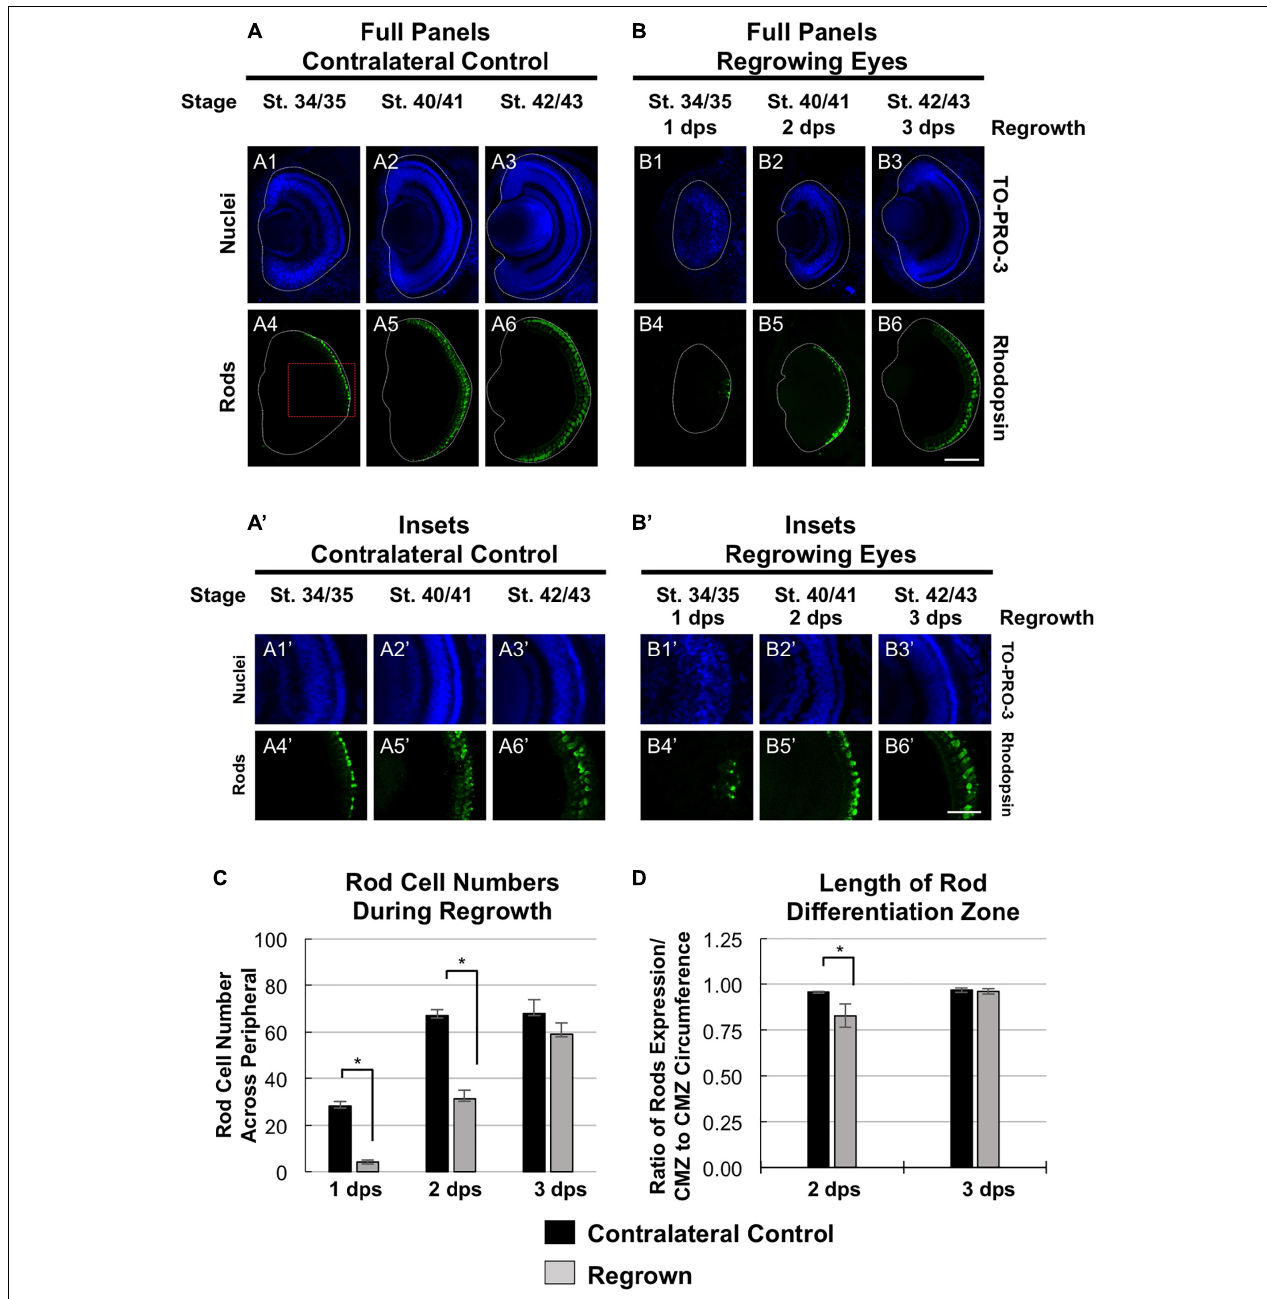
FIGURE 4 | Regrown eyes regain rod differentiation by 3 dps. Images shown are immunostained, transverse sections at three developmental timepoints corresponding to 1, 2, and 3 days post surgery (dps). (A,B) Differentiation of rod photoreceptor cells is delayed during 1, 2 dps but regains patterning that is comparable to contralateral control eyes (unoperated) by 3 days. White dashed lines delineate each eye. (A’,B’) Images shown in panels A’ and B’ correspond to the region shown in the inset box in panel A4 for the corresponding A or B panel at high magnification. Blue color indicates nuclear staining (TO-PRO-3). Green color indicates anti-Rhodopsin signal (rod photoreceptors). Sample sizes: 1 day, n = 5; 2 days, n = 7; and 3 days, n = 7. (A,B, A’,B’) Up = dorsal, down = ventral, lens is on the left. Scale bar: A,B = 100 µ m and A’,B’ = 50 µ m. (C) Quantification of rod photoreceptor cells in the regrowing eye structure at three developmental timepoints corresponding to 1, 2, and 3 dps. The number of rod photoreceptors per 60 µ m section in the regrown eye is comparable to number of rod photoreceptor cells in the contralateral control eyes by 3 dps. ∗ denotes p < 0.05 ( n > 5 per timepoint). Data are means ± SEM. (D) Rod photoreceptor cells expression pattern was measured and compared to the overall circumference of the retinal layer from one end of the ciliary margin zone (CMZ) to the end of the opposite CMZ in both regrowing and contralateral eyes. The ratio of rhodopsin expression in the retinal layer over the retinal layer circumference measurements is shown. By 3 dps, the rod photoreceptor cell expression is comparable to the contralateral control eye. ∗ denotes p < 0.05 ( n > 6 per timepoint). Data are means ± SEM.